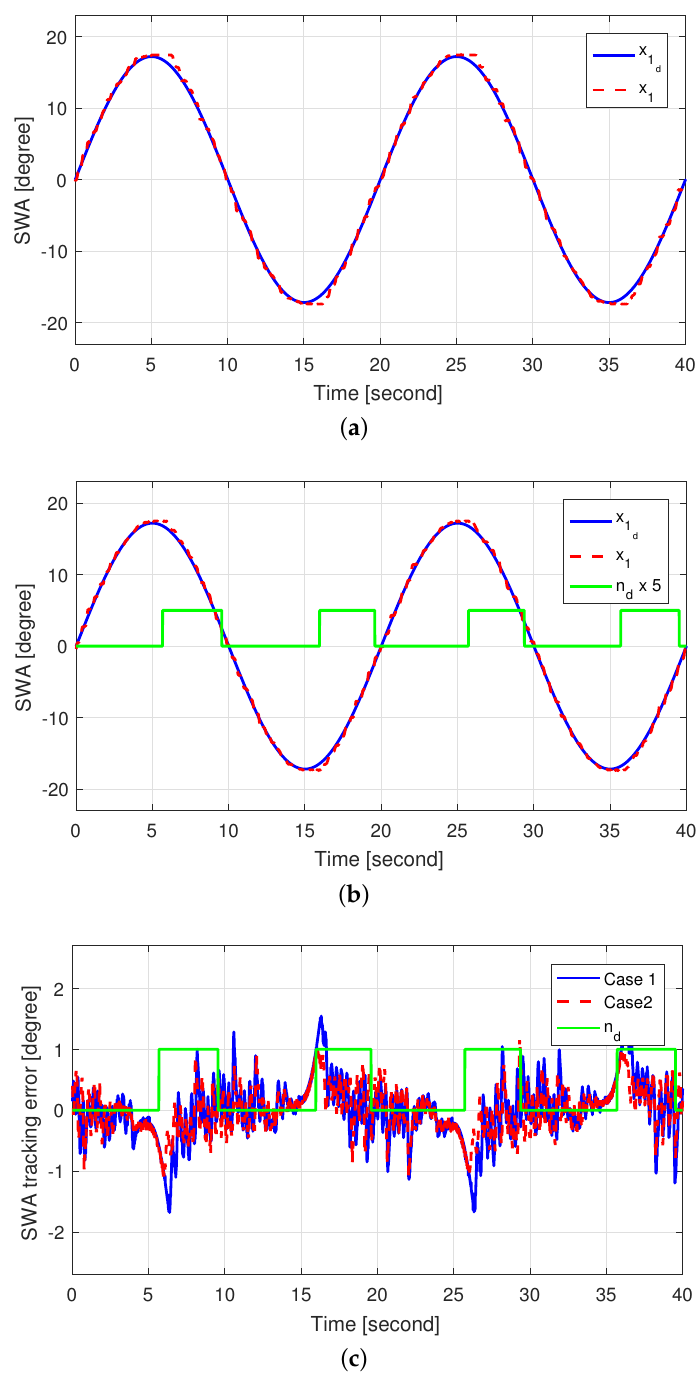
Figure 6. SWA tracking performance: ( a ) SWA tracking performance in case 1; ( b ) SWA tracking performance in case 2; and ( c ) SWA tracking error in cases 1 and